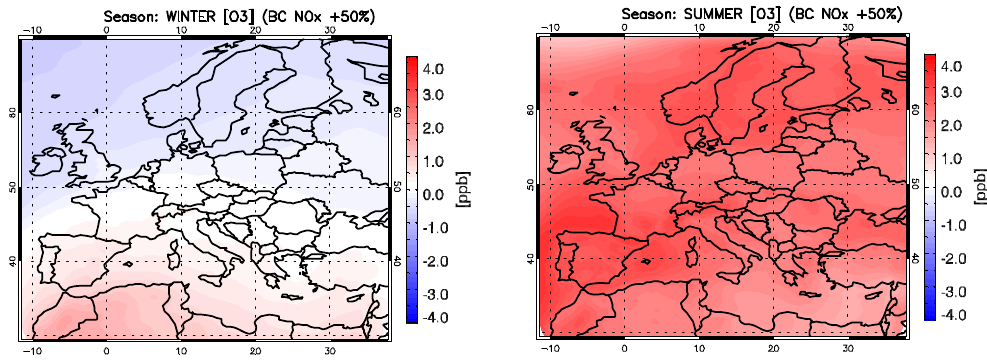
Fig. 12. Sensitivity studies with 50% NO x increase in the lateral boundary conditions. The plots show changes in seasonal average surface ozone concentrations for the winter (left) and the summer (right) season.